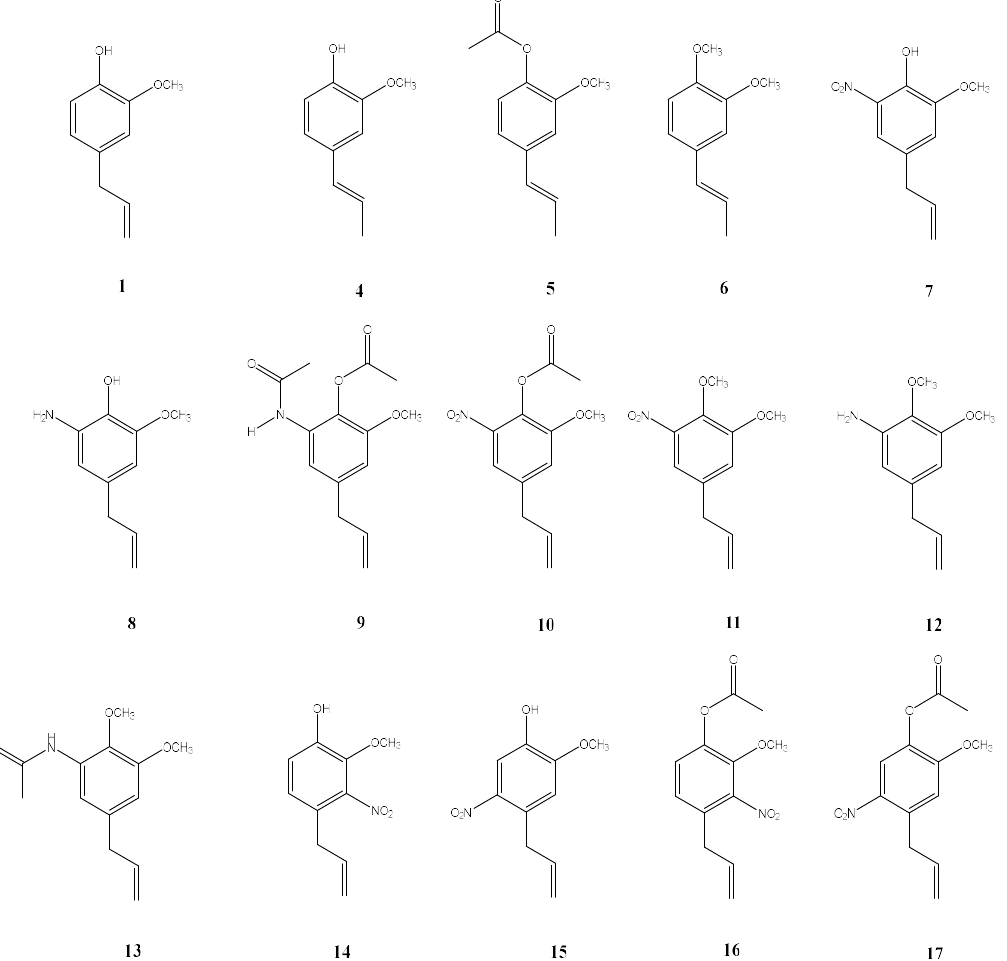
Figure 2. Chemical structures of synthesized eugenol derivatives.